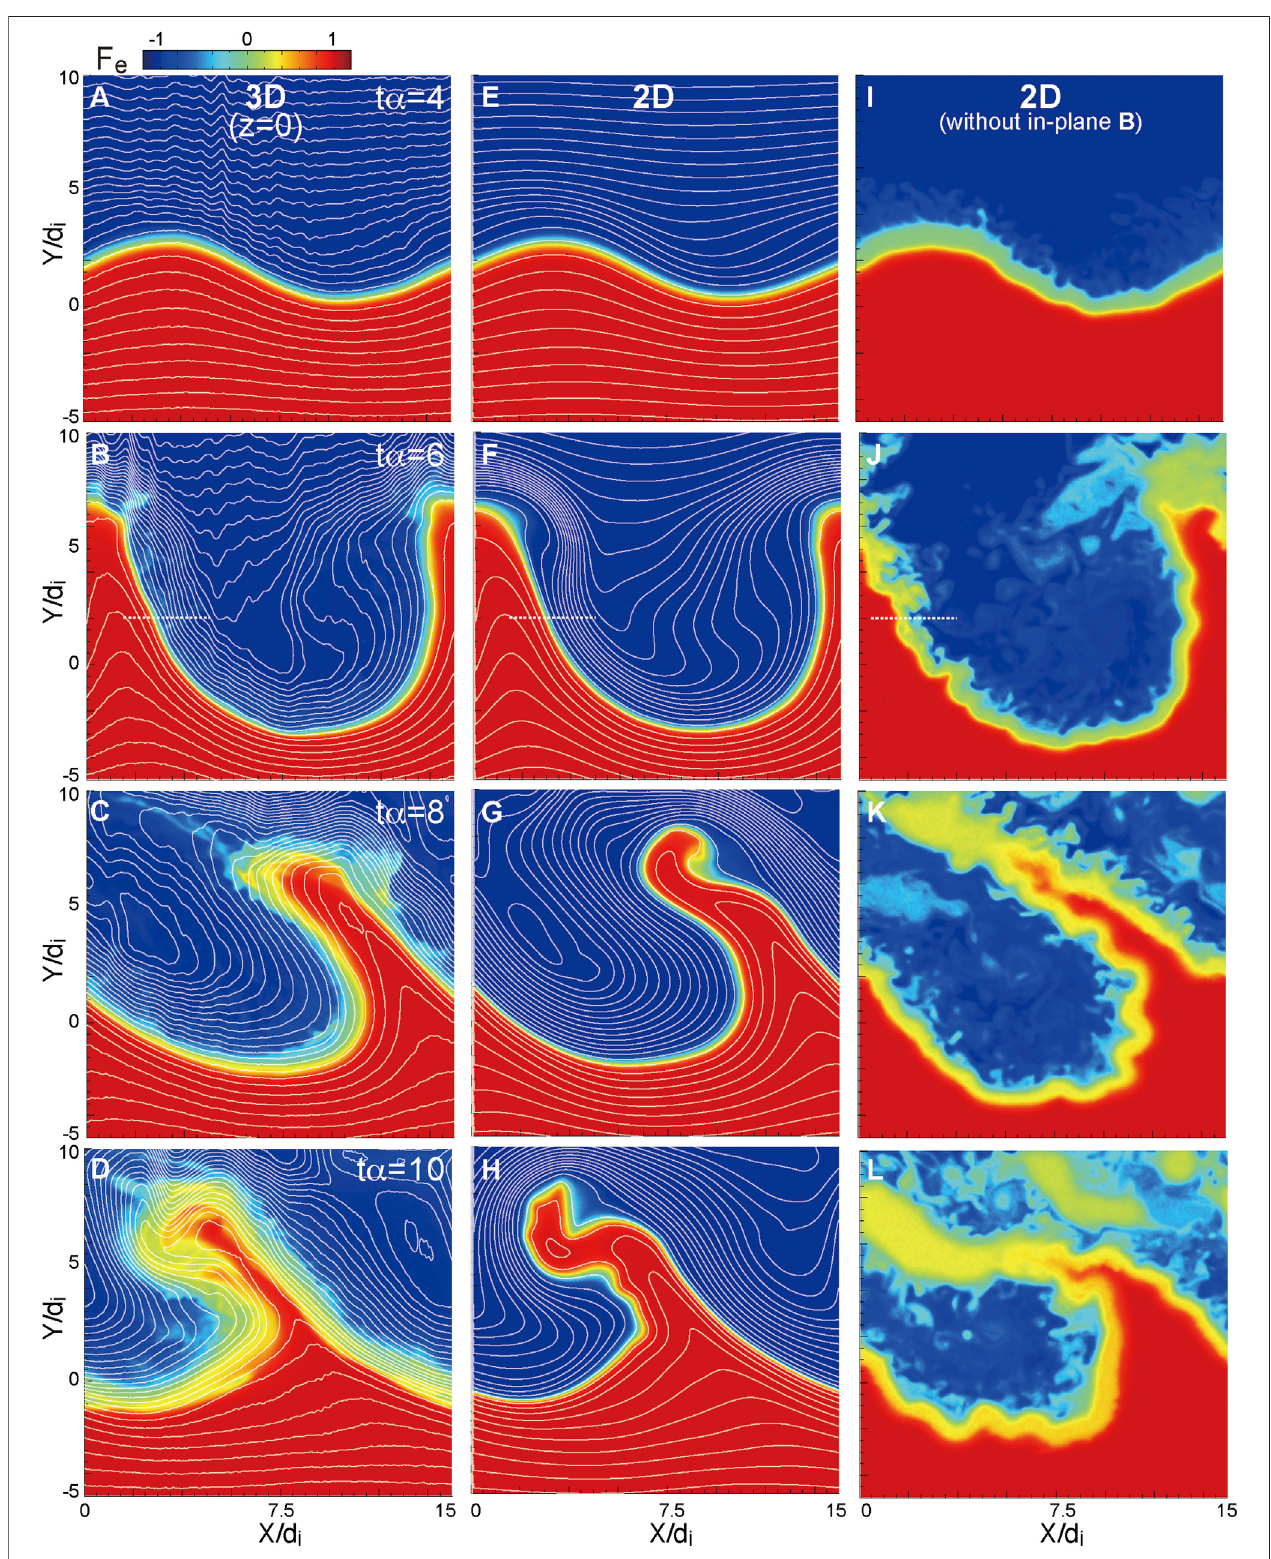
FIGURE1| Time evolutionofthemixingmeasure F e (cid:1) (n e1 -n e2 )/(n e1 +n e2 )in thex-yplane ( z (cid:1) 0forthe 3-Drun) forthe3-D (A – D) , thecorresponding2-D (E – H) ,and 2-Dwithoutinitialin-plane fi elds (I – L) runs.Thewhitecurvesforthe3-Dandcorresponding2-Drunsshowthesurfacesofthez-componentofthevectorpotential,which corresponds to the in-plane magnetic fi eld lines in 2-D.